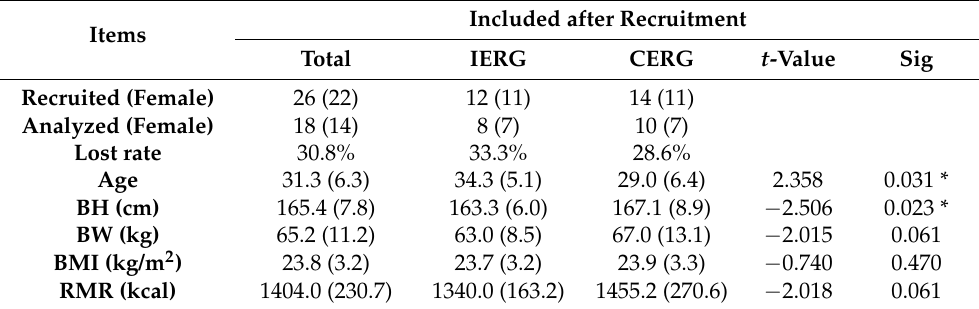
Table 1. Participants’ characteristics in the baseline.